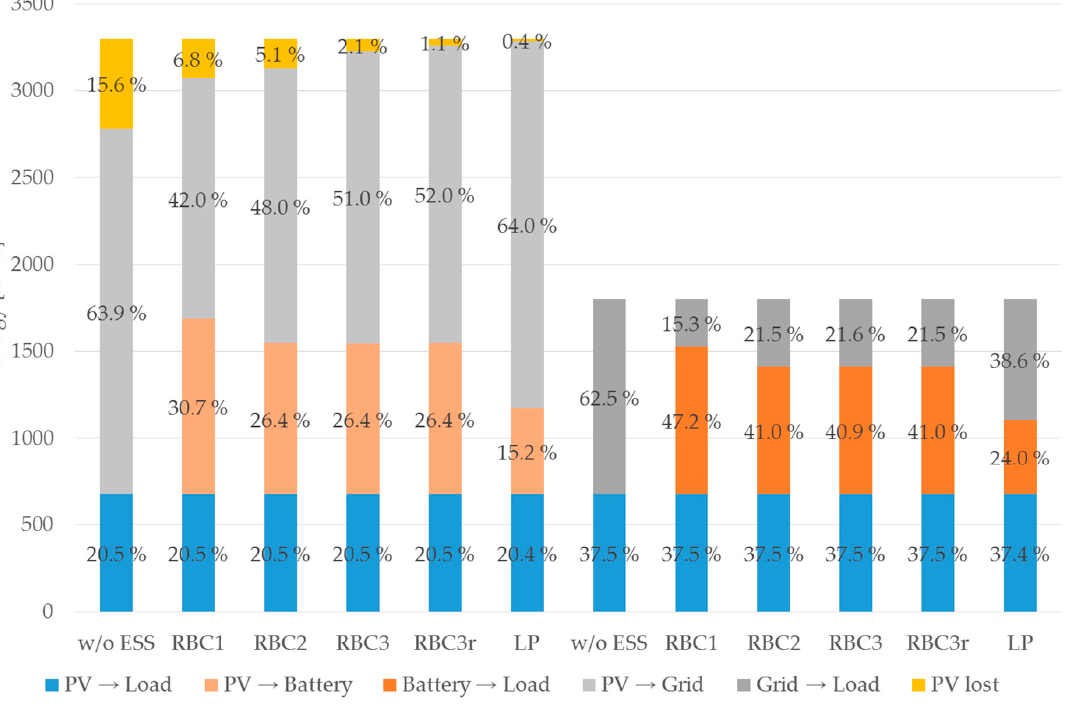
Figure 18. PV lost and battery losses. The main conclusions of this section are: